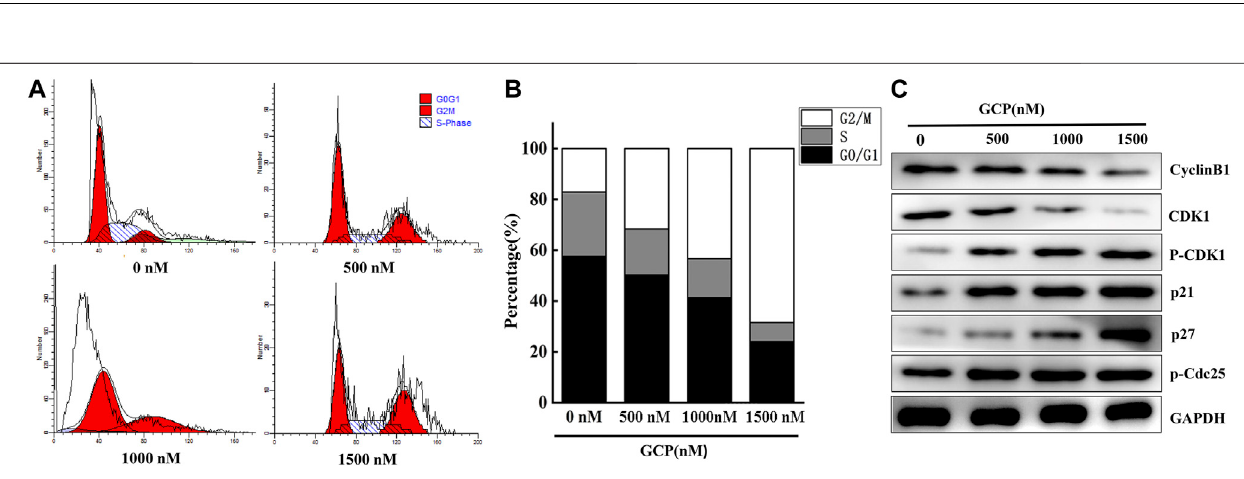
FIGURE 4 | GCP induces cell cycle G2/M arrest in HeLa cells. (A, B) The HeLa cells were treated with different dose of GCP for 48 h, and the distribution of cell cyclewasassessedby fl owcytometry.Thepercentageofcellsineachphaseisshownasmean ± SDfromthreeindependentexperiments. (C) Theexpressionofrelated protein was analyzed by western